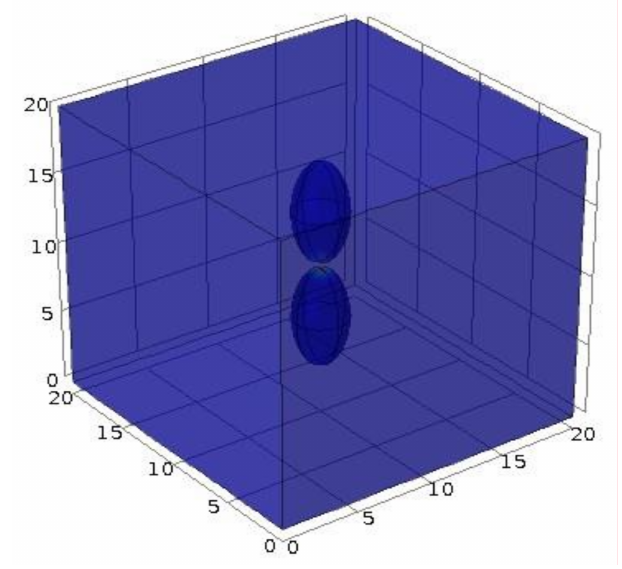
Figure 15. A cubic cell of 20 × 20 × 20 µ m with two water